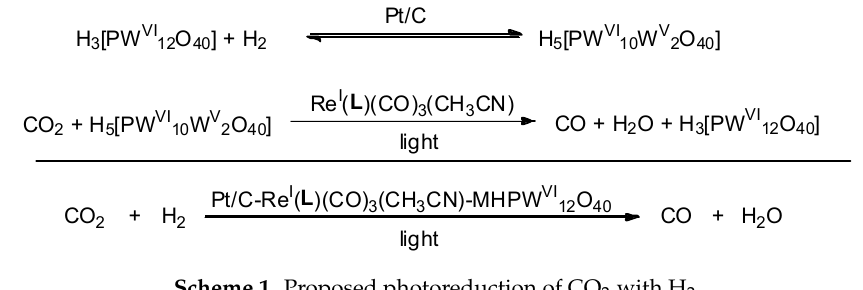
Figure 4. Re I (L)(CO) 3 -NaHPW 12 O 40 presenting the complexation of two [PW 12 O 40 ] 3– units to Na. H atoms and solvent molecules are omitted. C, black ball; N, blue ball; O, red ball; P, purple ball; Na, yellow ball; Re, green ball; W, gray ball. Reprinted with permission from [41]. Copyright© 2011 American Chemical Society.